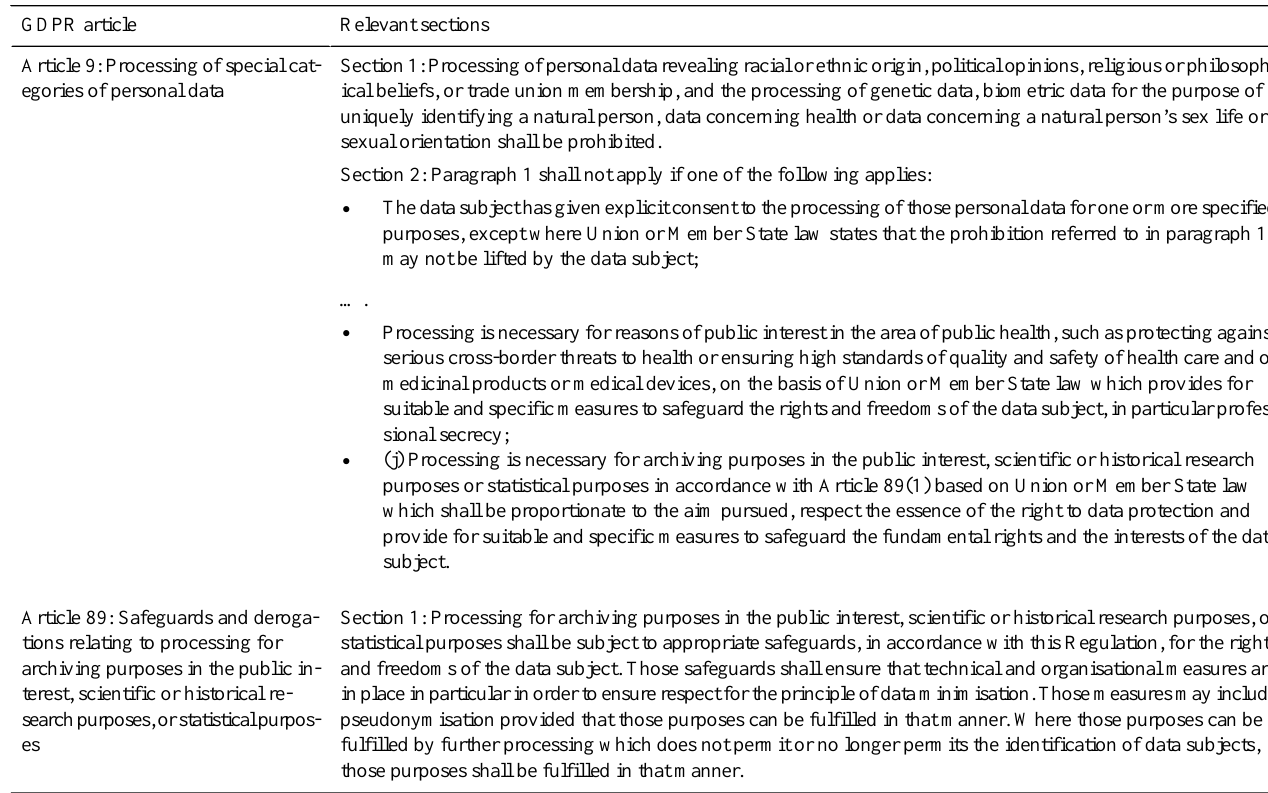
Table 1. Scientific research exemption provisions of the European Union’s General Data Protection Regulation (GDPR). Relevant sectionsGDPR